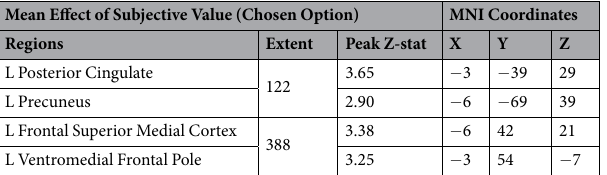
Ventral Striatum D2Rs (PET) and subjective value representations (fMRI).